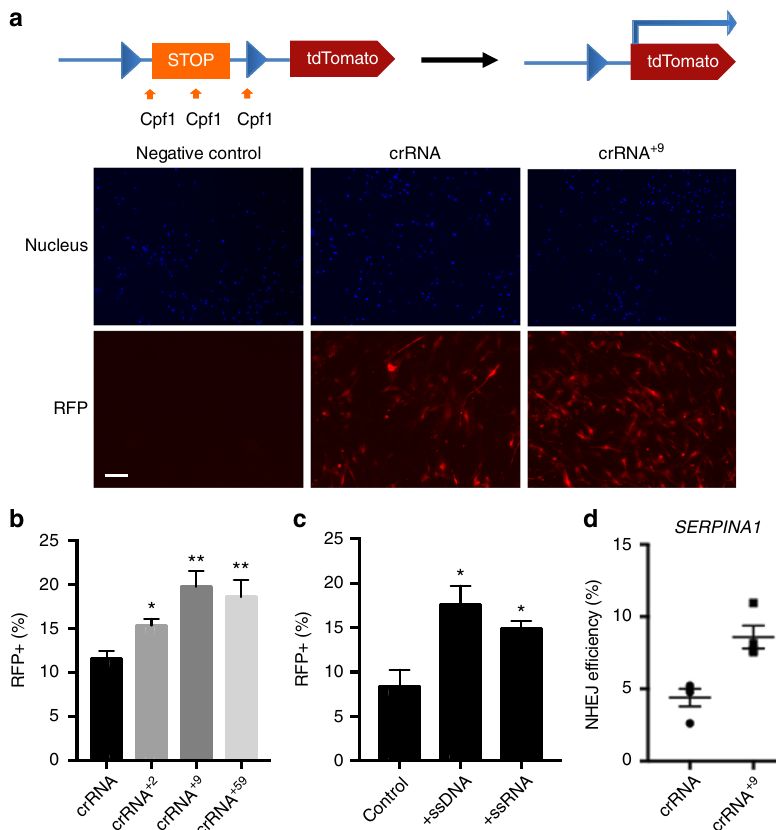
Fig. 4 The nuclease activity of Cpf1 is enhanced with 5 ′ -terminal extensions in primary myoblasts and HepG2 cells. a Fluorescence images of primary ai9 myoblasts after Cpf1 RNP delivery. Negative control had no treatment. Cpf1 RNP and Cpf1 RNP + 9 were delivered into cells using electroporation. Hoechst staining visualized the nucleus and RFP expression is visualized in red. Scale bar is 100 µ m. b 5 ′ Extensions of crRNA enhance Cpf1 gene editing in primary ai9 myoblasts. Quanti fi cation of RFP + resulting from target sequence deletion after electroporation of Cpf1 RNPs with various crRNA 5 ′ extensions. Mean ± SE, n = 3. * p < 0.05, ** p < 0.01 by Student ’ s t test compared to crRNA control. c Addition of ssDNA or ssRNA enhances the gene editing ef fi ciency of Cpf1 RNP. Cpf1 RNP was transfected to ai9 myoblasts with either 100 nt ssDNA or 100 nt ssRNA (no sequence homology to target DNA). Quanti fi cation of RFP + cells indicates that single-stranded nucleic acids enhance the gene editing ef fi ciency of the Cpf1 RNP. Mean ± SE, n = 3. * p < 0.05 by Student ’ s t test compared to control. d Extended crRNA increases the gene editing ef fi ciency of Cpf1 RNP in HepG2 cells. Cpf1 RNP designed to target the SERPINA1 gene was delivered into HepG2 cells using electroporation. Droplet digital PCR (ddPCR) was conducted on genomic DNA from the HepG2 cells to quantify NHEJ ef fi ciency. Mean ± SE, n = 4, p = 0.0057 by Student ’ s t test compared to crRNA